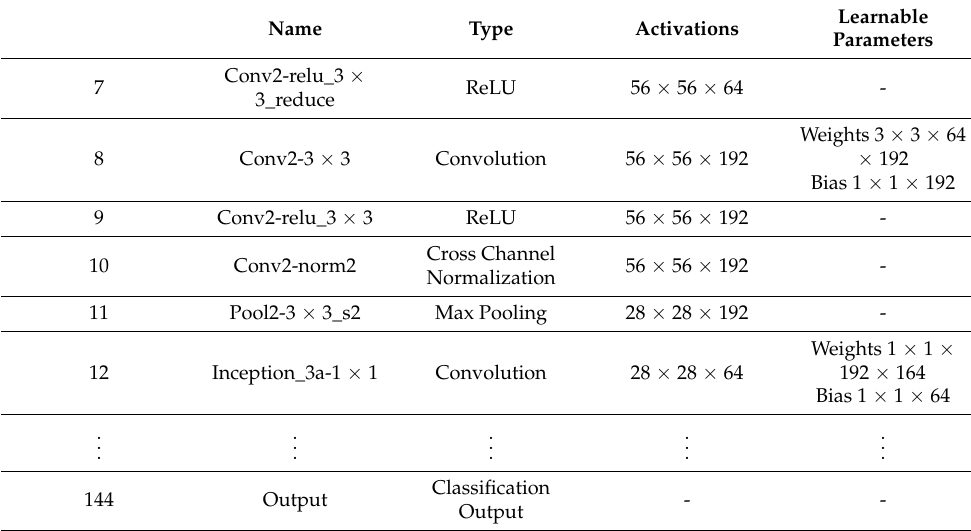
Figure 10. Experiment II: accuracy of nine classes (CRC-VAL-HE-7K).